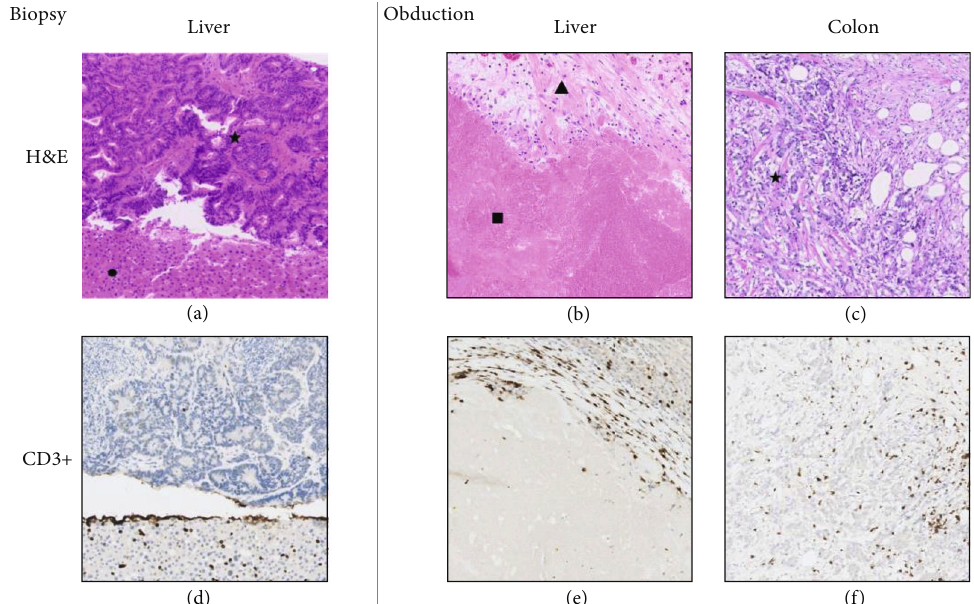
Figure 3: Histopathology of primary tumor and liver metastases. H&E staining of liver and colon sections (a – c). Liver biopsy sections with an asterisk showing colorectal metastasis and a circle showing preexistent liver tissue (a), liver obduction sections with a square showing necrosis and a triangle showing fi brosis (b), and colon carcinoma obduction sections with an asterisk showing colon tumor tissue (c). CD3+ staining of liver and colon sections (d – f). Liver biopsy sections, liver obduction sections, and colon obduction sections all show a sparse lymphocytic T-cell in fi ltrate. Magni fi cation of (a), (b), (d), and (e) is 25x and (c) and (f) is